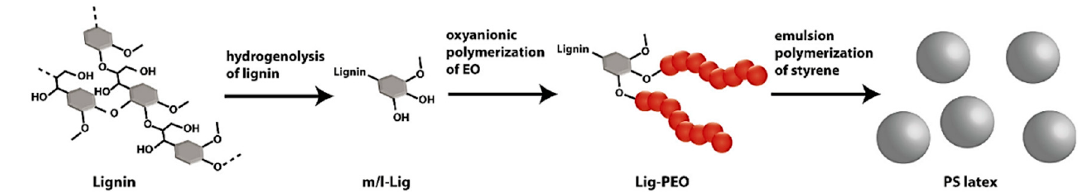
Figure 29. Lignin-based surfactants and their utilization in emulsion polymerization. Reproduced with permission [98].